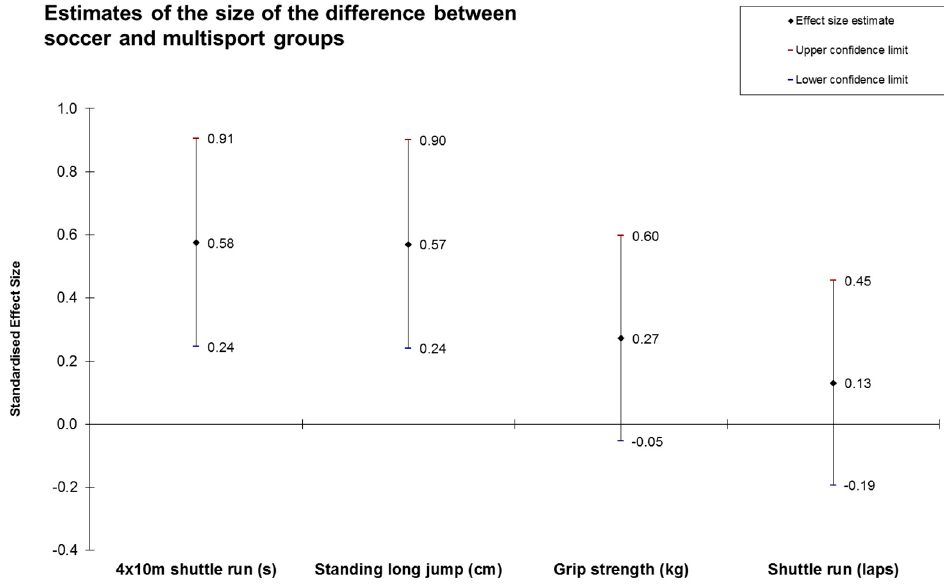
Figure 2. Standardized mean differences and 95% confidence intervals (Cohen’s d ± 95%) between soccer and multisport in 4 × 10 m shuttle run, standing long jump, grip strength, and 20 m shuttle run test.